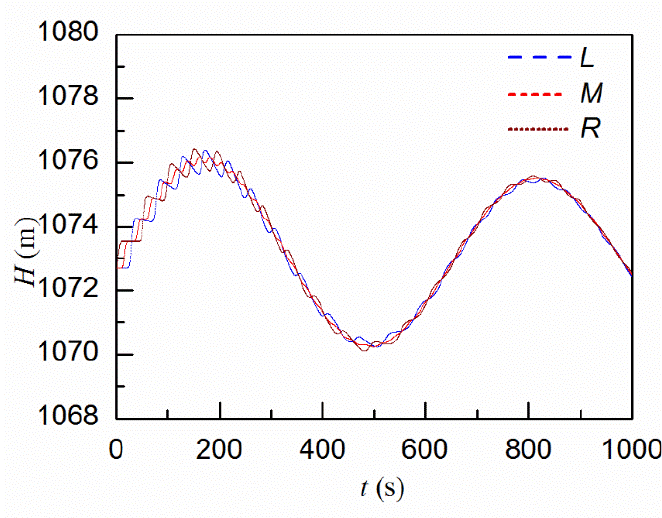
Figure 11. Comparison of the water levels in the sand basin at different positions ( L 1 = 2400 m, h = 10 m, w = 10 m).